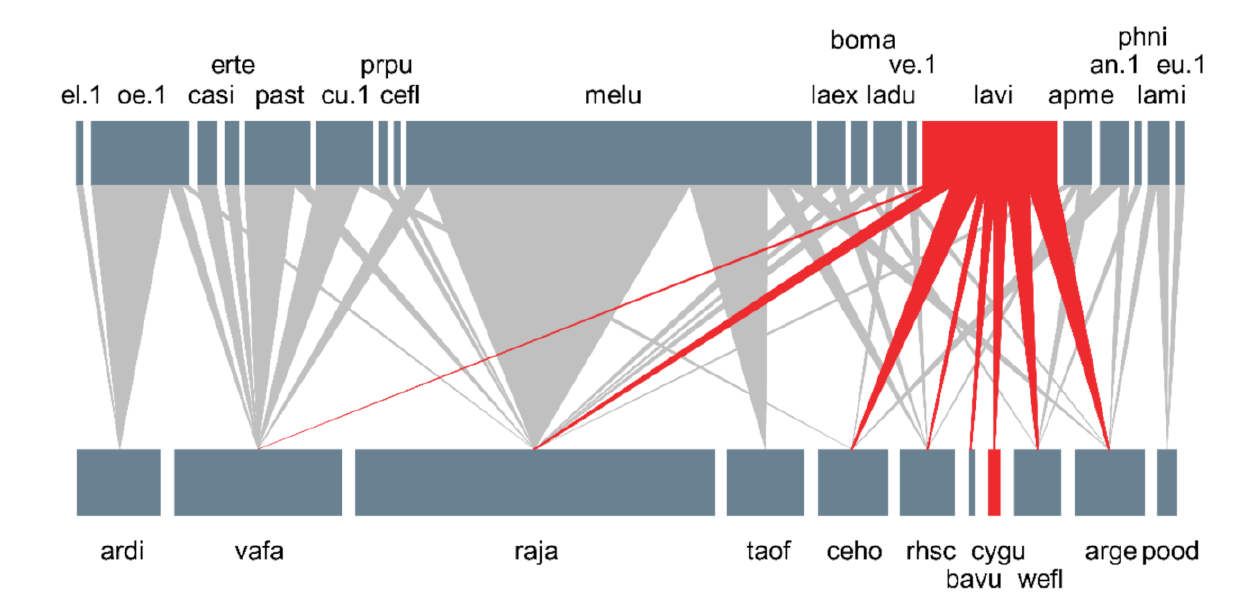
Figure 4. Plant–pollinator network in the natural habitat of the critically endangered orchid Cypri- pedium guttatum . The upper and lower boxes indicate pollinators and plants, respectively. The width of each box and vertical line are proportional to the interaction frequency. The red upper box and vertical lines indicate interaction diversity and the abundance of Lassioglossum virideglaucum , and the lower red box represents C. guttatum (pollinator: an. 1 = Andrena sp. 1, apme = Apis mellifera , boma = Bombylius major , casi = Carterocephalus silvicola , cefl = Ceratina flavipes , cu. 1 = Curculionidae sp. 1, el. 1 = Elateridae sp. 1, erte = Eristalomyia tenax , eu. 1 = Eucera sp. 1, laex = Lasioglossum exiliceps, ladu = Lasioglossum duplex , lavi = Lasioglossum virideglaucum , lami = Lasioglossum miyabei , melu = Metasyrphus luniger , oe. 1 = Oedemeridae sp. 1, past = Parnassius stubbendorfii , phni = Philopota nigroaenea , prpu = Pristomyrmex pungens , ve. 1 = Vespidae sp. 1; Plant: arge = Arabis gemmifera , ardi = Aruncus dioicus var. kamtschaticus , bavu = Barbarea vulgaris , ceho = Cerastium holosteoides var. hallaisanense , cygu = Cypripedium guttatum , pood = Polygonatum odoratum var. pluriflorum , raja = Ra- nunculus japonicus , rhsc = Rhododendron schlippenbachii , taof = Taraxacum officinale , vafa = Valeriana fauriei , wefl = Weigela florida